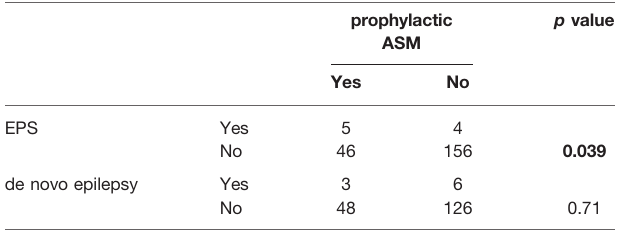
TABLE 5 | The relationship of EPS, de novo epilepsy and prophylactic ASM.